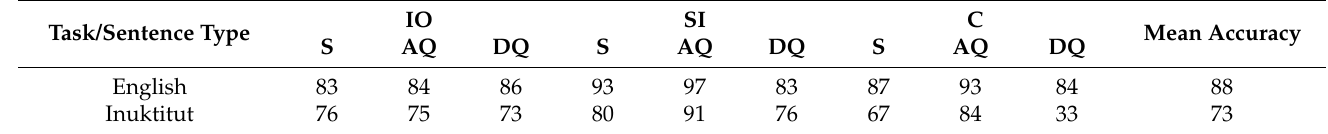
Table 5. Proportion of accurate responses by Task and Sentence Type organized by language group.